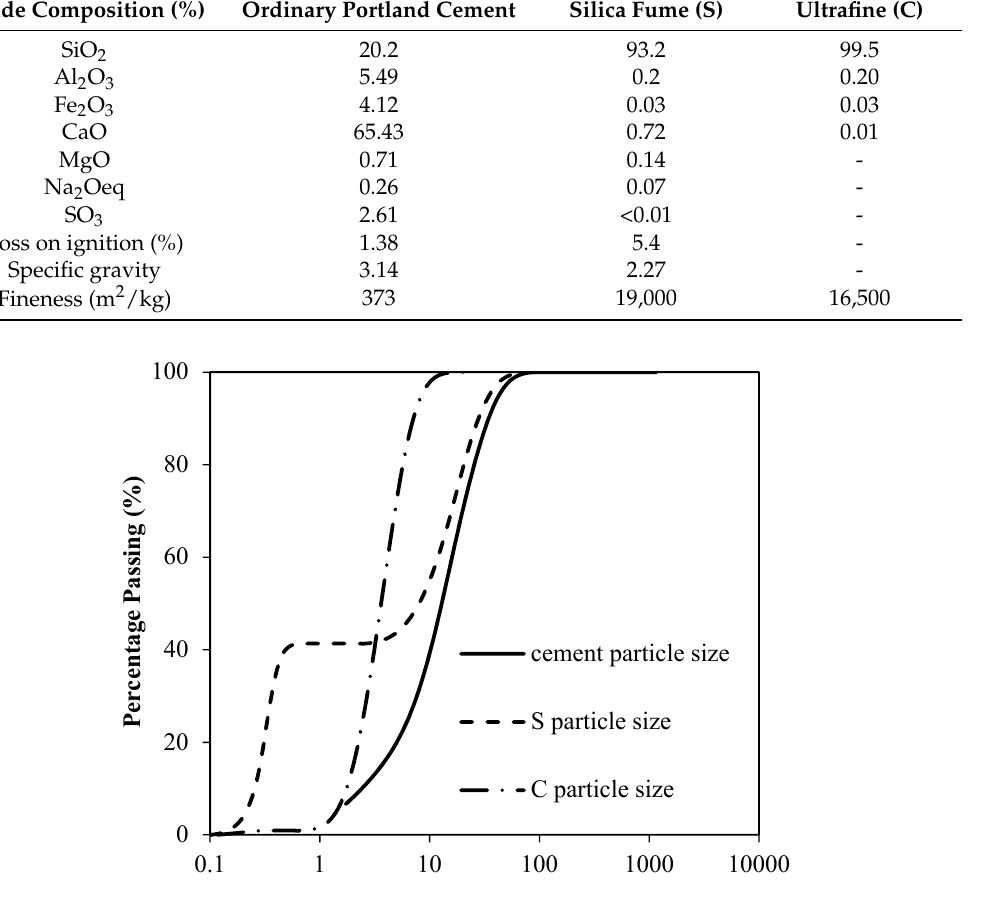
Table 1. Physical and chemical properties of cementitious materials.